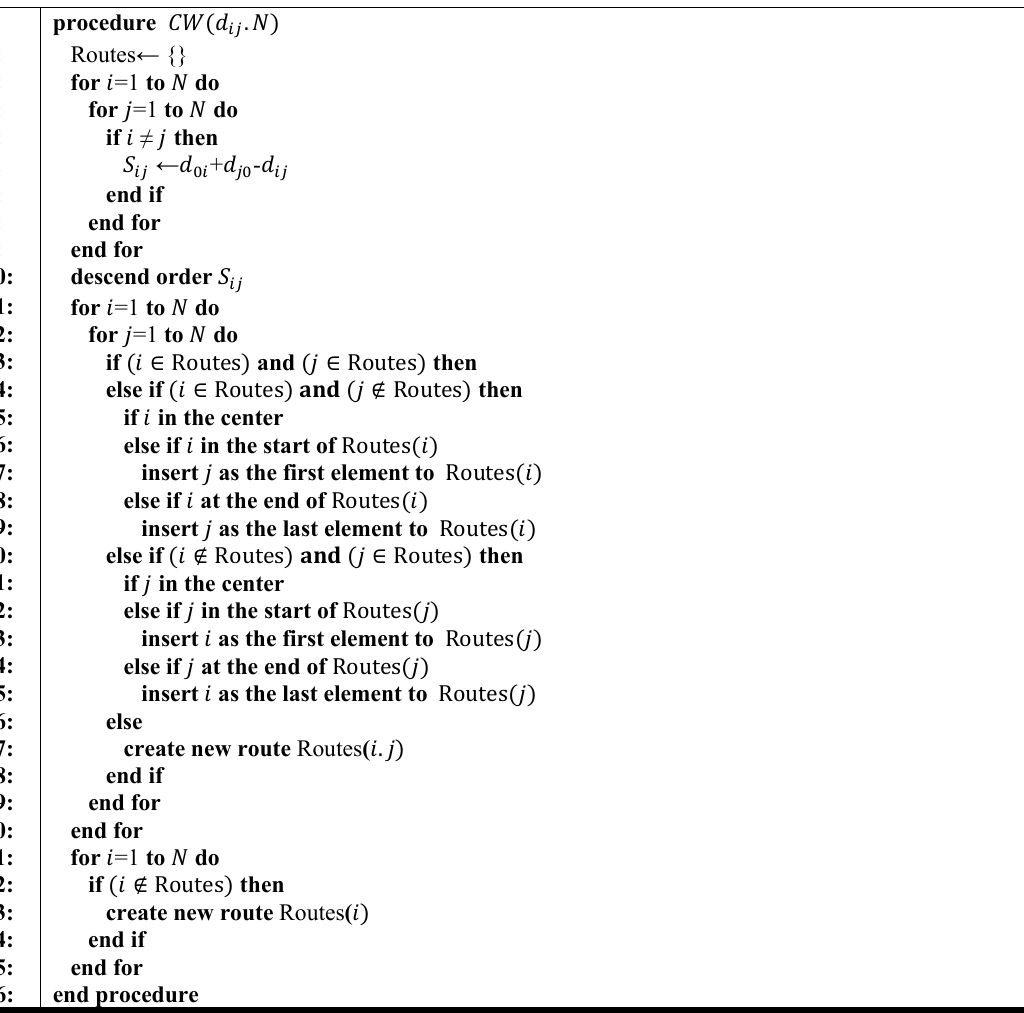
Algorithm 1 Savings